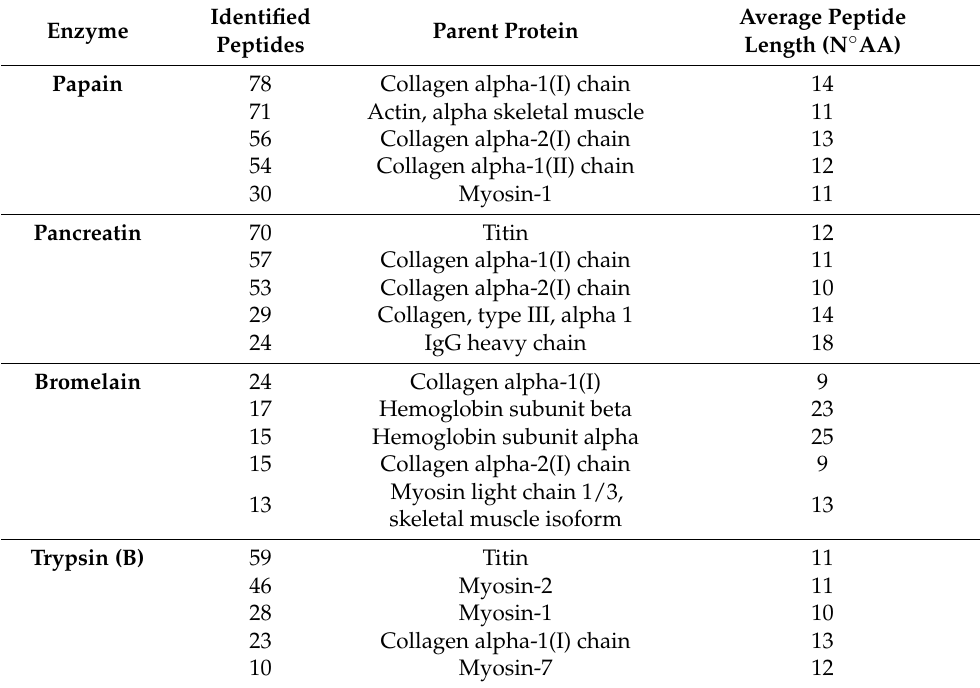
Table 3. Identification by Linear Trap Quadrupole-OrbiTrap of the main peptides in digestates obtained after enzymatic hydrolysis of calf fleshing meat, and of the proteins of origin. Proteins are listed according to the highest number of peptides generated [12]. AA, amino